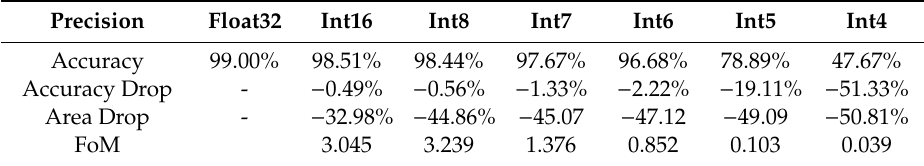
Table 3. Accuracy and area comparison of di ff erent precision.